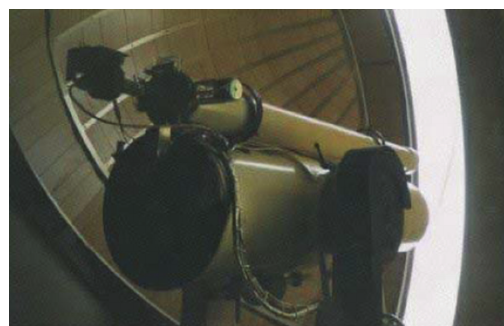
Figure 7: The 0.4 m Automatic Imaging Telescope of Perugia University, adapted from [42].